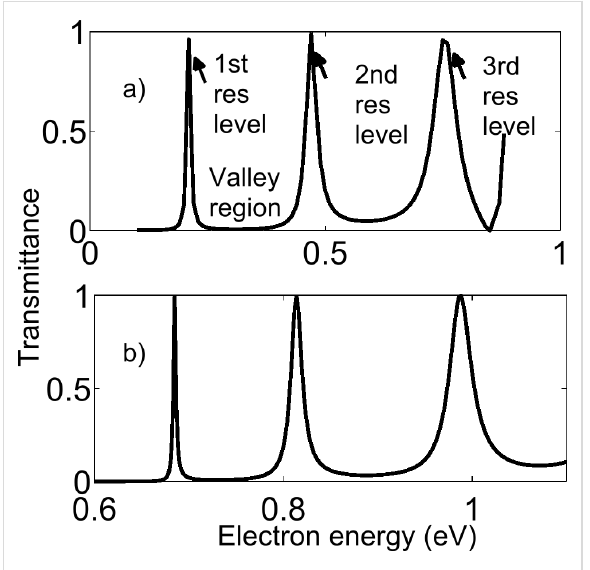
Figure 3: Transmittance versus change in electron energy for graphene nanoribbon MZI structure (a) zigzag type (b) armchair type.